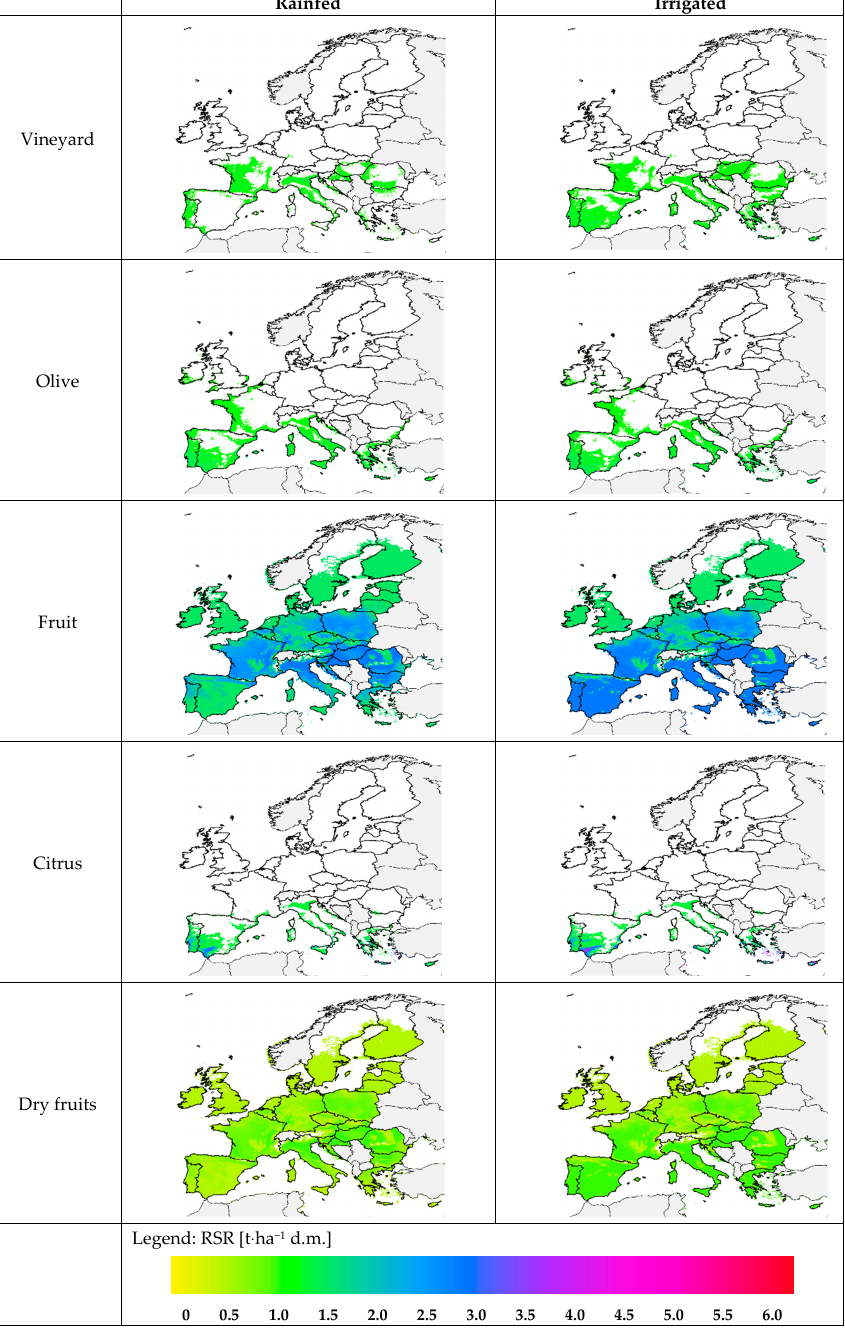
Figure 5. Productivity of pruning residue under rainfed and irrigated conditions estimated as surface ratio RSR (t ⋅ ha − 1 d.m.) for five crop groups.